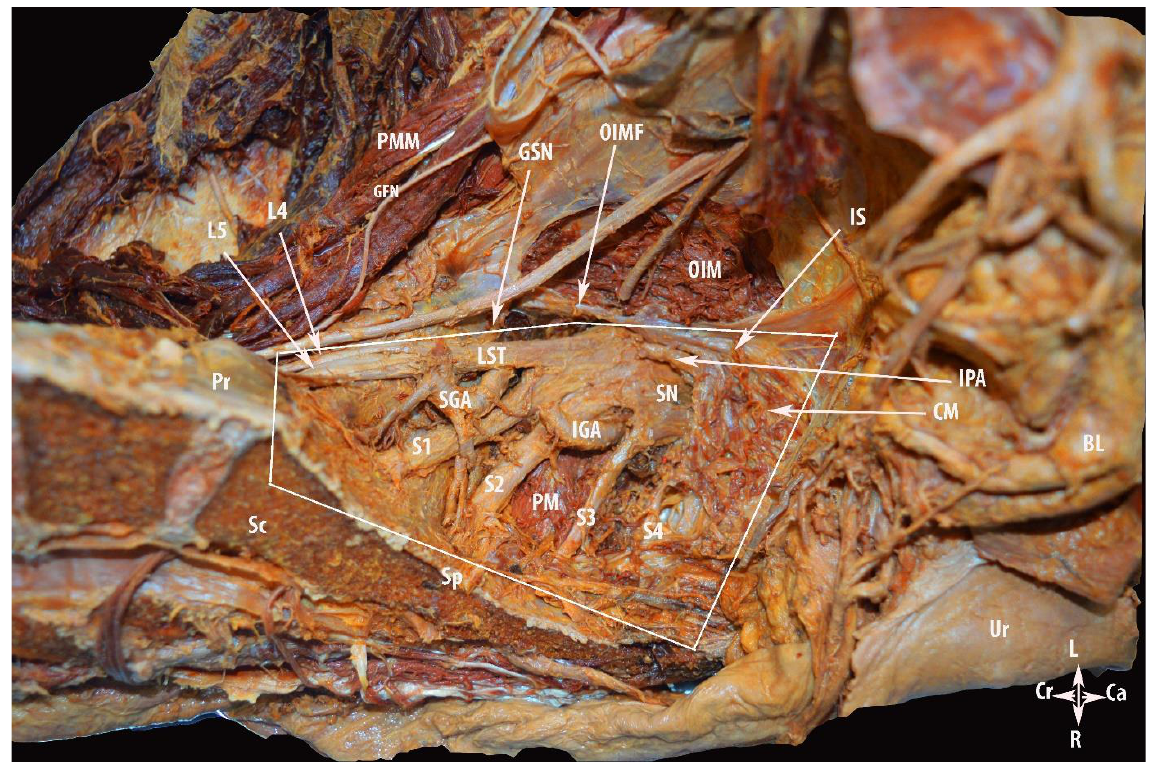
Figure 8. Limits of the nerve region of the pelvic sidewall . For better visualization of anatomical structures, the external iliac vessels and part of the internal iliac vessels are removed . PMM — psoas major muscle; GFN — genitofemoral nerve; GSN — greater sciatic notch; OIMF — obturator internus muscle fascia; OIM — obturator internus muscle; LST — lumbosacral trunk; S1, S2, S3 and S4 — anterior rami of the sacral spinal nerves; L4 and L5 — anterior rami of the lumbar spinal nerves; SGA — superior gluteal artery; IGA — inferior gluteal artery; IPA — internal pudendal artery; PM — pi- riformis muscle; SN — sciatic nerve; CM — coccygeus muscle; IS — ischial spine; BL — bladder; Ur — uterus; Sp — sacral spine; Sc — sacrum; Pr — promontory; L — left; R — right; Ca — caudal; and Cr — cra- nial.